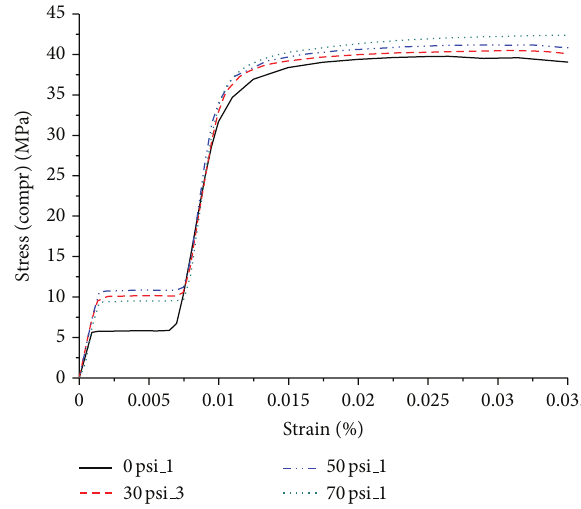
Figure 17: Stress-strain comparison of CFRP specimens manufac- tured under 0, 30, 50, and 70psi derived from compression